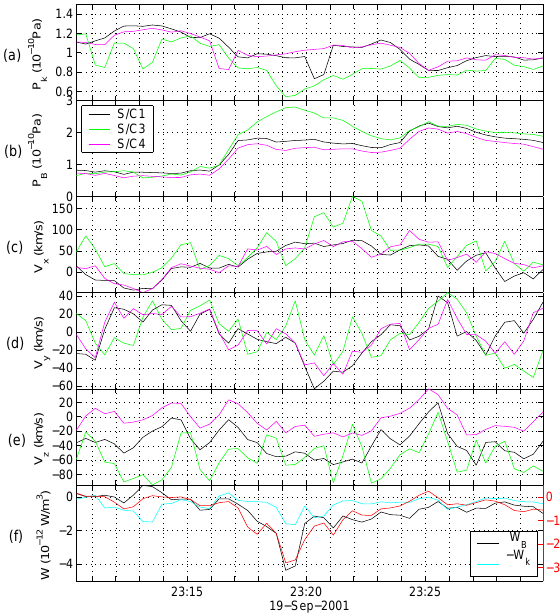
Fig. 7. The same as for Fig. 6 but for CGR2.